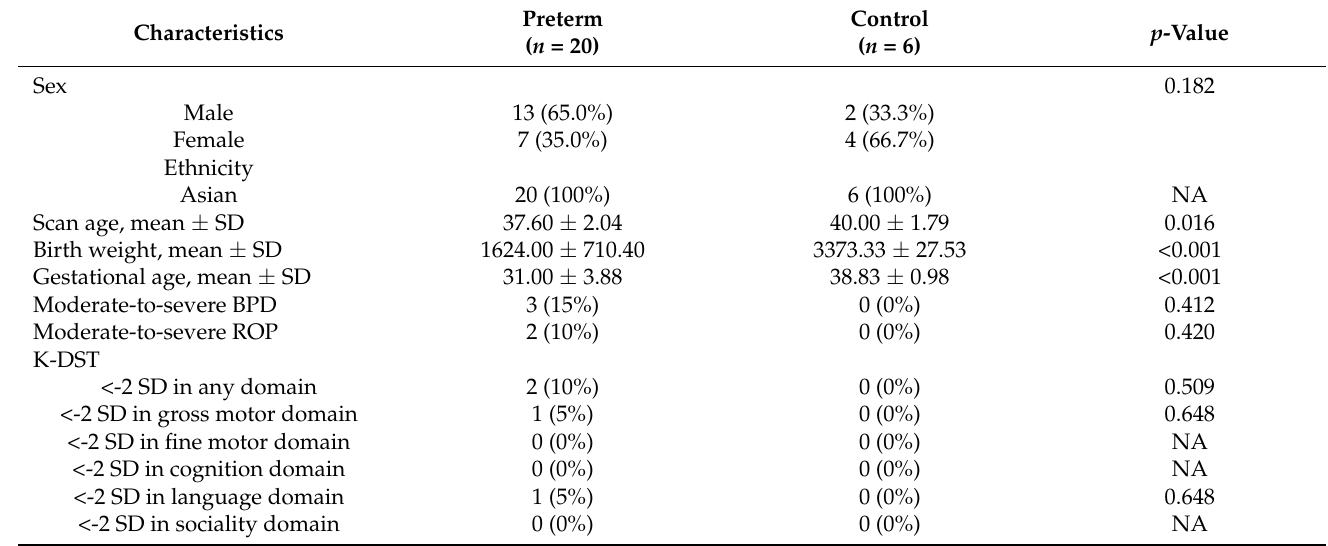
Table 2. Descriptive characteristics of the